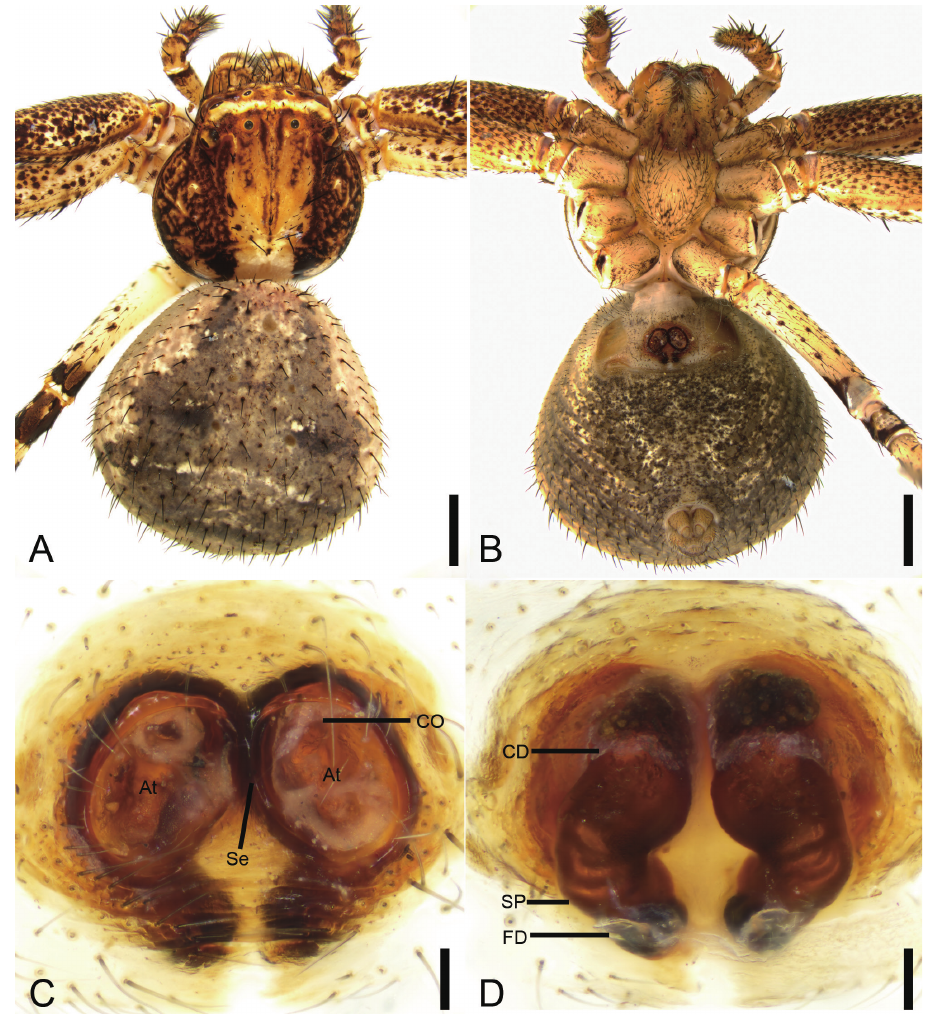
Figure 14. Xysticus lesserti Schenkel, 1963, female. A habitus, dorsal view B same, ventral view C epigyne, ventral view D same, dorsal view. Abbreviations: At – atrium, CD – copulatory duct, CO – copulatory opening, FD – fertilisation duct, Se –septum, SP – spermatheca. Scale bars: 1 mm ( A, B ), 0.1 mm ( C, D